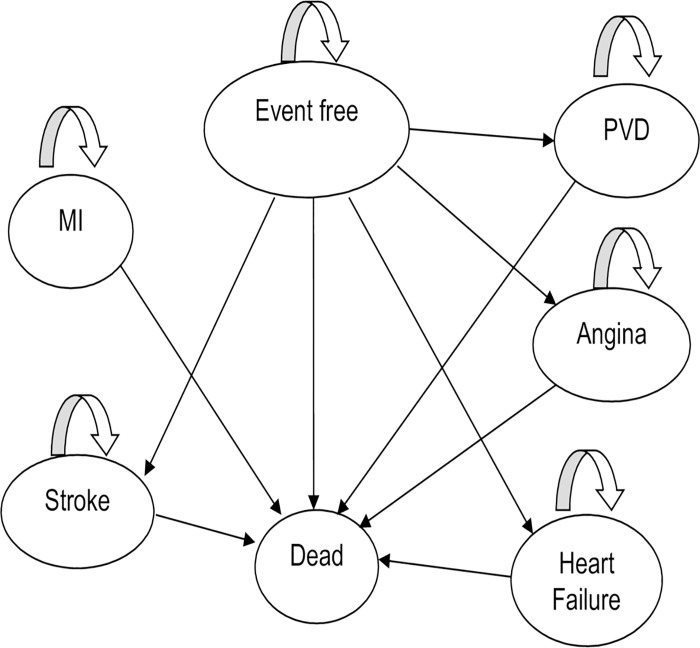
Model health states.